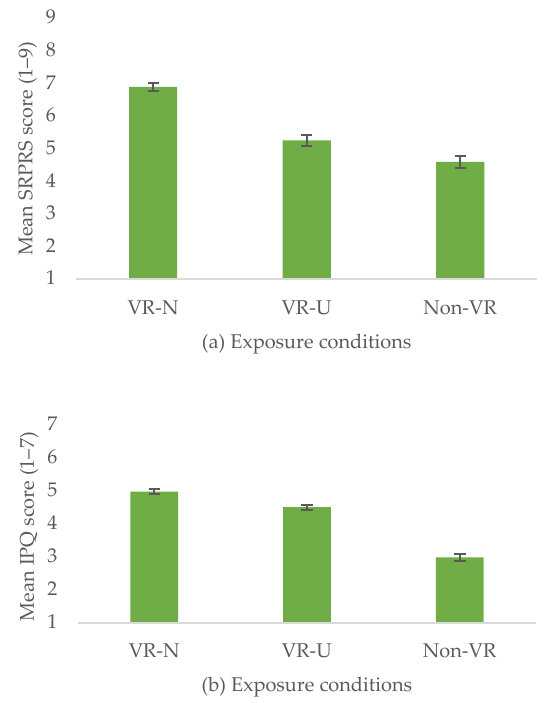
Figure 5. Comparison of mean scores across three types of nature exposure for ( a ) perceived restor- ativeness and ( b ) perceived presence. Error bars represent standard error.